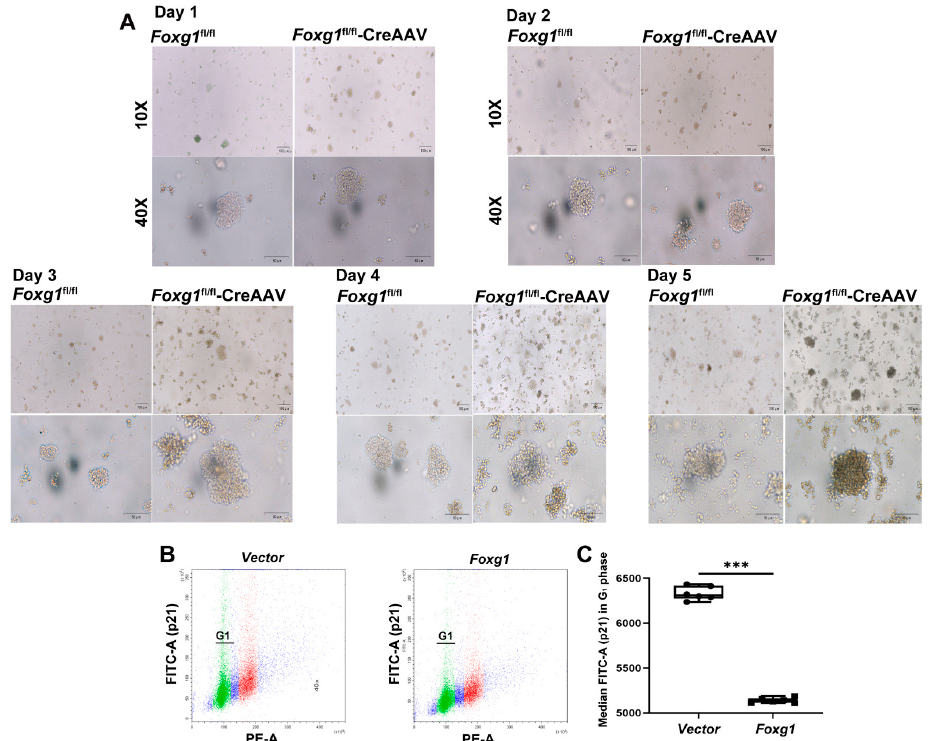
the hippocampal DG of Foxg1 genotype mice were assessed with immunofluorescence. Red = GFAP; Green = Proliferating Cell Nuclear Antigen (PCNA); Blue = DAPI. Scale bars = 100 µ m. Arrow heads: proliferated qNSCs. ( J ) Levels of qNSCs in adult hippocampus are showed as %GFAP + /DAPI + cells. ( K ) Levels of proliferated qNSCs in adult hippocampus are showed as %GFAP + PCNA + /DAPI + cells. ( I ) Expression patterns of activated aNSCs in the hippocampal DG of Foxg1 genotype mice were assessed with immunofluorescence. Red = brain lipid binding protein (BLBP); Green = GFAP; Blue = DAPI. Scale bars = 100 µ m. Arrow heads: activated aNSCs. ( L ) Levels of aNSCs in adult hippocampus are showed as %GFAP + /DAPI + cells. ( M ) Levels of activated aNSCs in adult hippocampus are showed as %GFAP + BLBP + /DAPI + cells. Values are expressed as means ± S. E. M. n = 6/group. Significant levels set at *** p < 0.001 noted difference between Foxg1 fl/fl and Foxg1 fl/fl -CreAAV animals. ns—not significant.